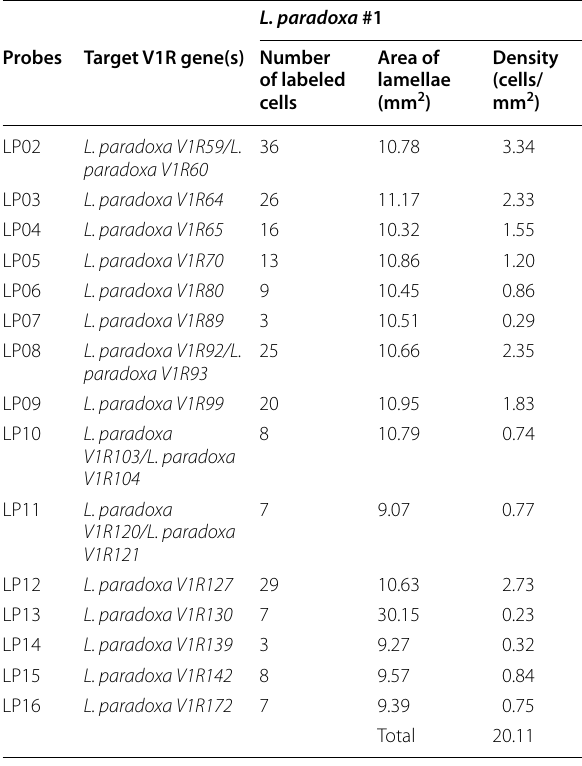
Table 3 Density of cells labeled by single probes for V1Rs in the lamellae of L.